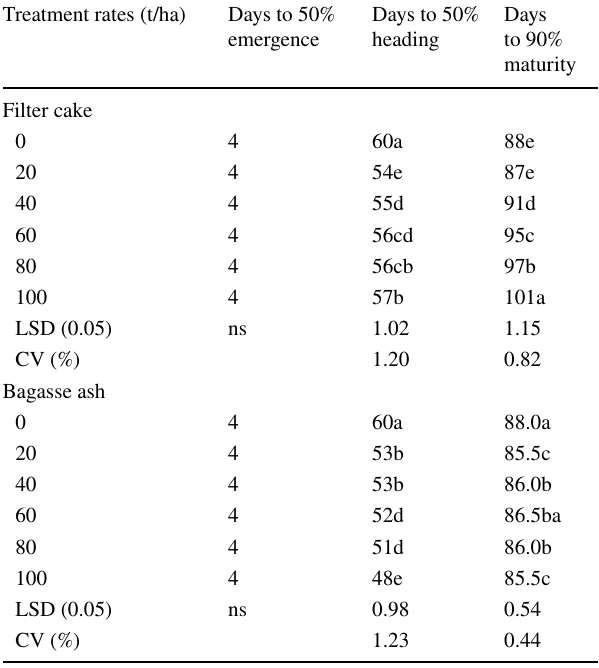
Table 4 Effect of filter cake and bagasse ash application on durum wheat phenology